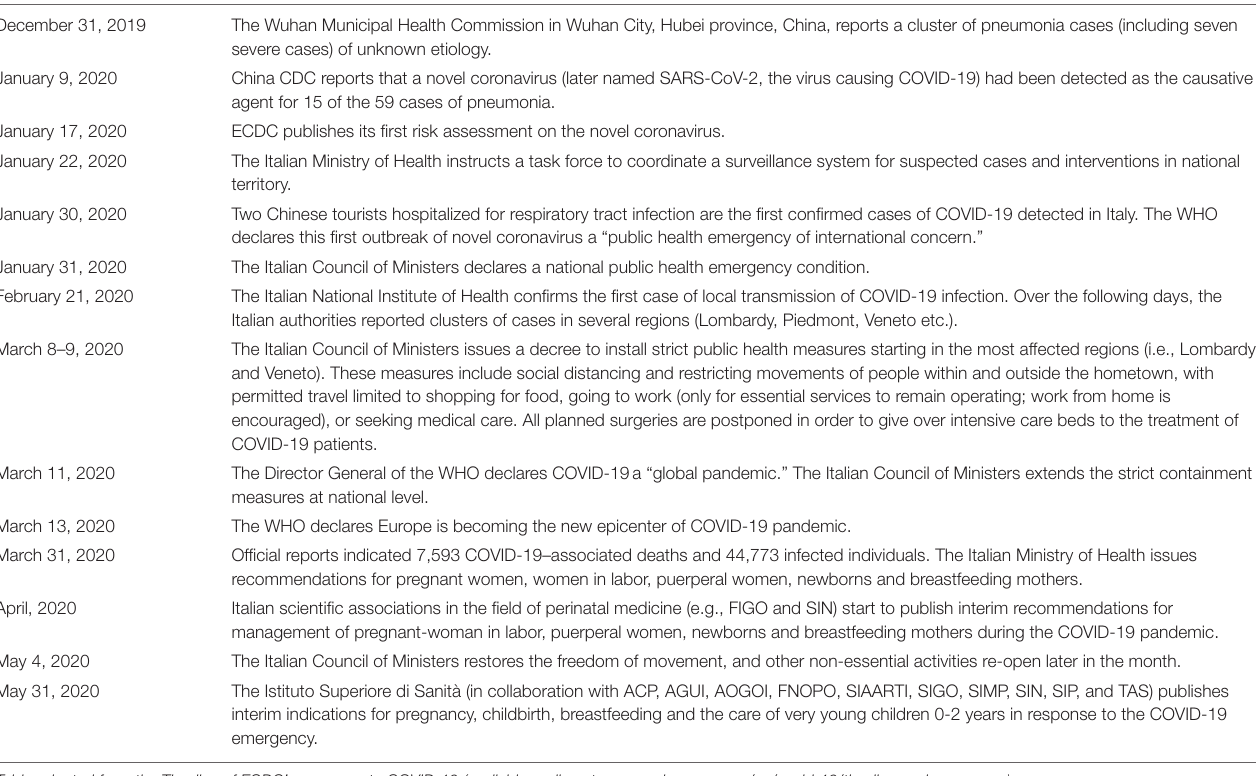
TABLE 1 | Timeline of the COVID-19 pandemic in